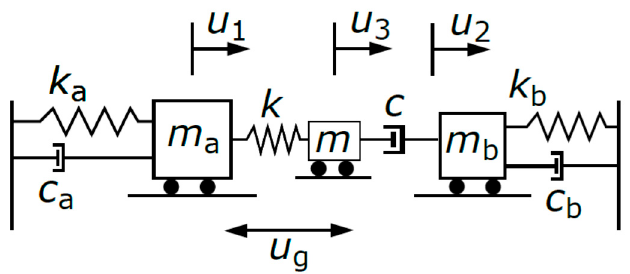
Figure 1. Schematic representation of a tuned mass damper (TMD) shared by two buildings modeled as single degree of freedom (SDOF) systems.